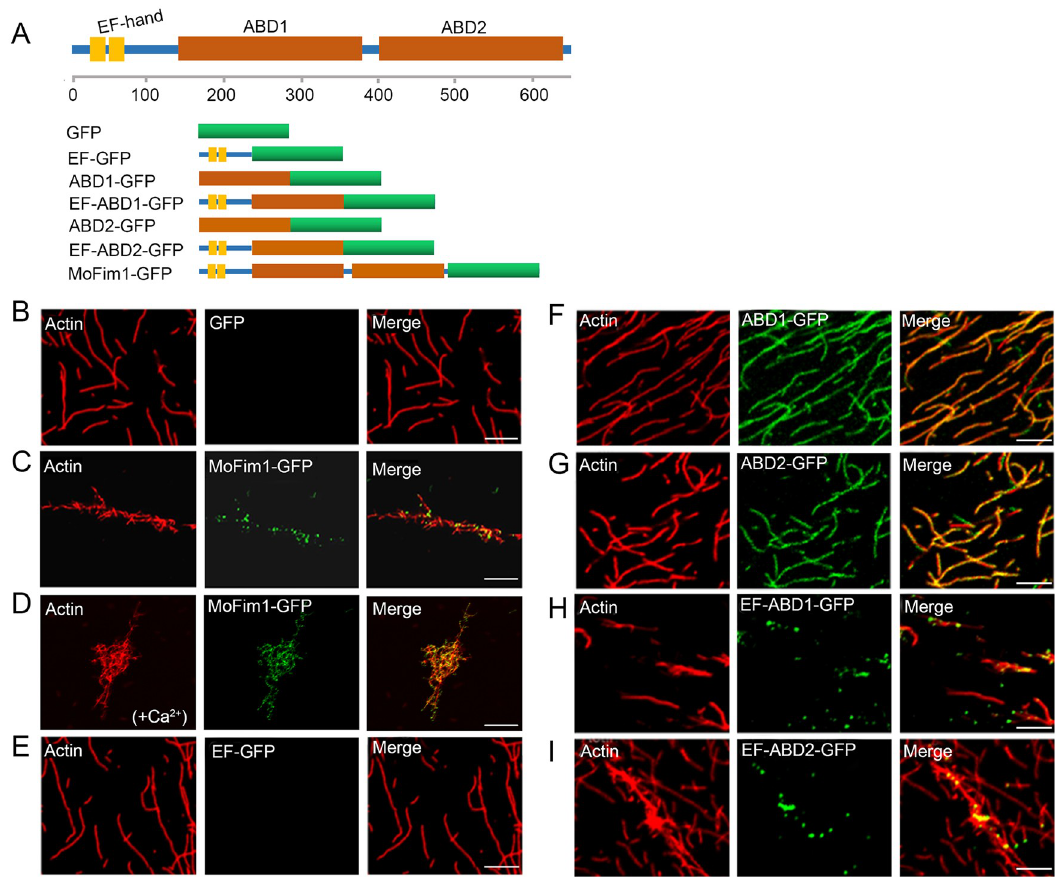
Fig 5. Biochemical analysis of MoFim1. (A) Schematic diagram showing the protein domains of MoFim1 and GFP-fused MoFim1 and truncated proteins. (B–I) Actin binding/bundling analysis of MoFim1 and its various domains by fluorescence observation. Polymerized F-actin (1 μ M) incubated with various proteins (1 μ M) was used for analysis. Alex561-phalloidin-labeled F-actin alone (B) ; F-actin in the presence of MoFim1-GFP (C) ; F-actin in the presence of MoFim1-GFP and Ca 2+ (1 μ M) (D) ; F-actin in the presence of EF-GFP (E) ; ABD1-GFP (F) ; ABD2-GFP (G) ; EF-ABD1-GFP (H) and EF-ABD2-GFP (I) . Bars = 1 μ